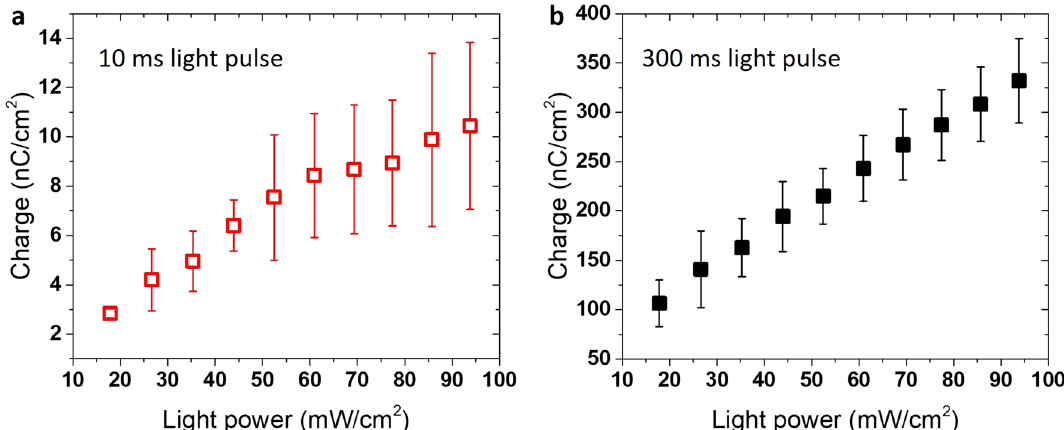
Figure 3. Total charge measured upon photo-stimulation. Photo-generated charge calculated from the time integral of the photocurrent response curves as a function of increasing light power for 10 ms ( a ) and 300 ms ( b ) light pulse duration. Samples n = 3. Y-error bar referred to the Standard Deviation (SD) are shown. (OriginPro 2016 was